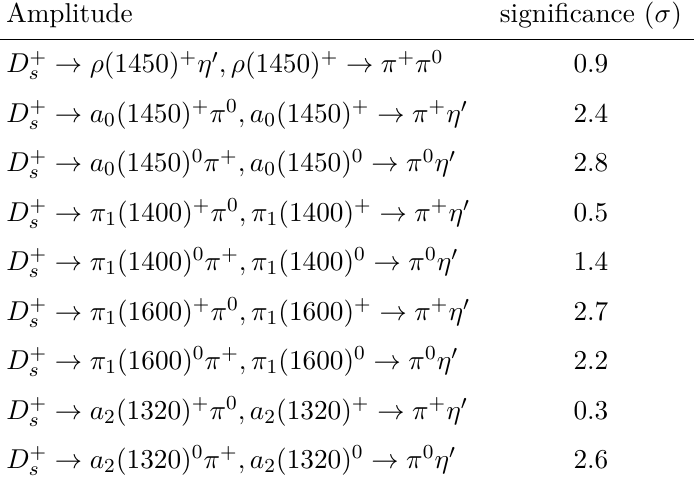
Table 4 . Tested amplitudes, but not included in the nominal